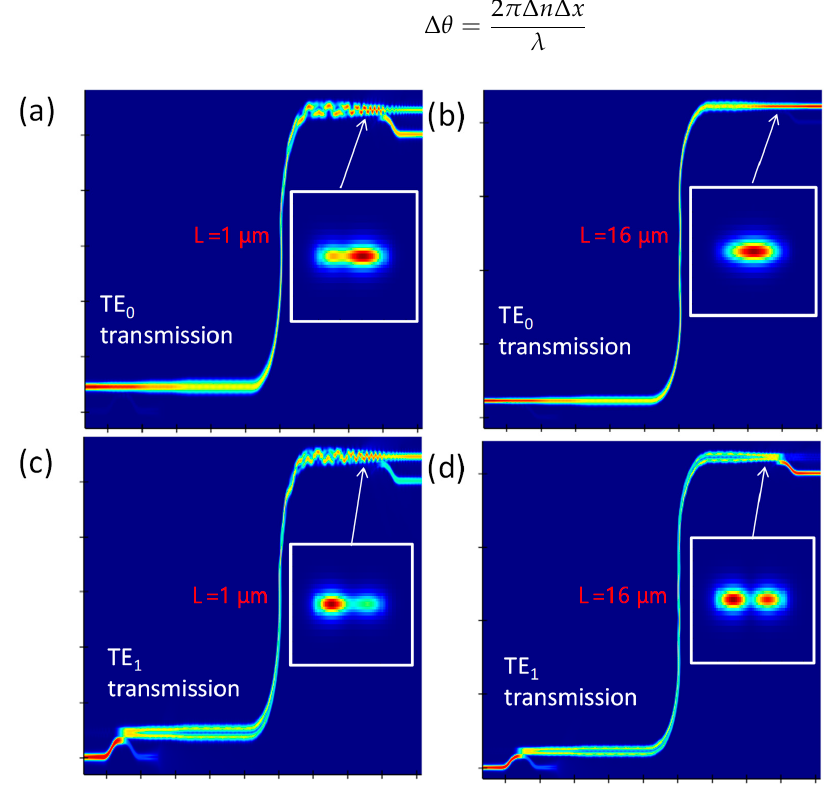
Figure 5. FDTD simulation results of TE 0 mode transmission at waveguide lengths ( a ) L = 1 μ m, and ( b ) L = 16 μ m; and TE 1 mode transmission at waveguide lengths ( c ) L = 1 μ m, and ( d ) L = 16 μ m. Table 1. Simulated mode crosstalk of the Euler